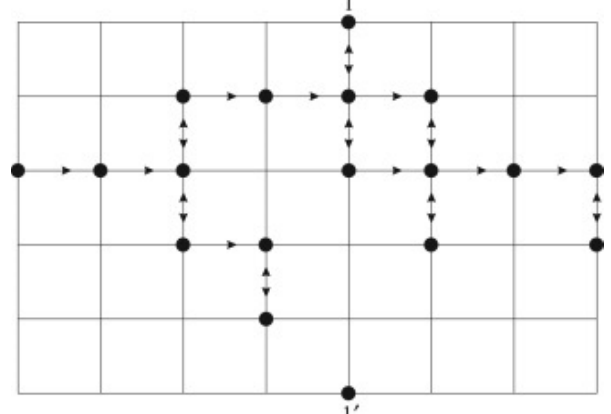
Figure 17. A semi-directed site percolation cluster on the square lattice, containing N = 17 sites (filled circles) on a strip of width n = 5, due to periodic boundary conditions the sites denoted by 1 and 1 ′ , are identified. The strip is infinite along the horizontal axis (the preferred direction). In contrast to the case of fully directed percolation, vertical lines of the lattice are not directed, which means that the set of all semi-directed percolation clusters includes the set of all possible fully directed clusters [54].